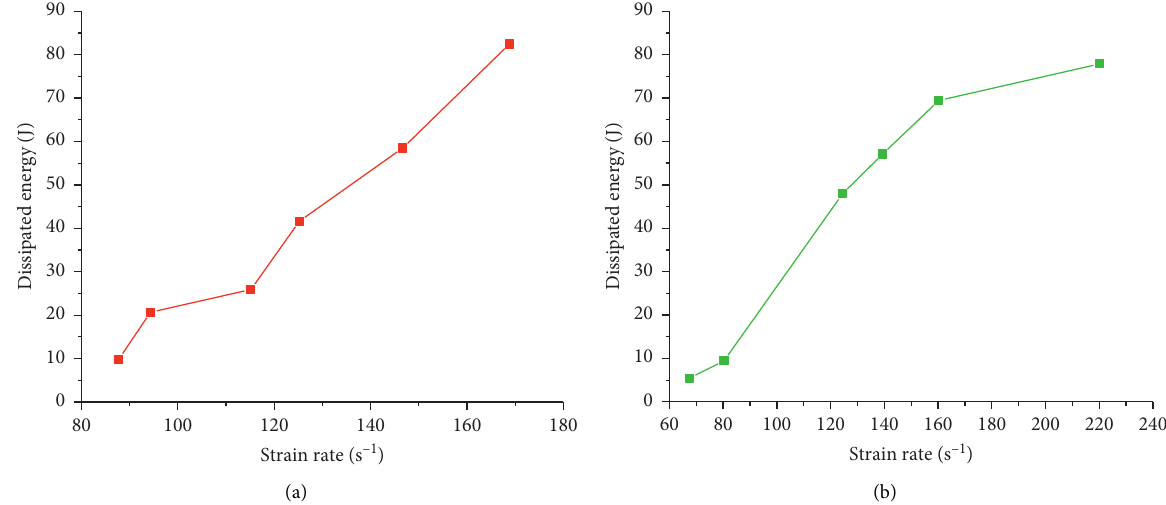
Figure 11: Variation of dissipated energy of coal samples with strain rate. (a) Rockburst-prone coal samples. (b) Nonprone coal samples.